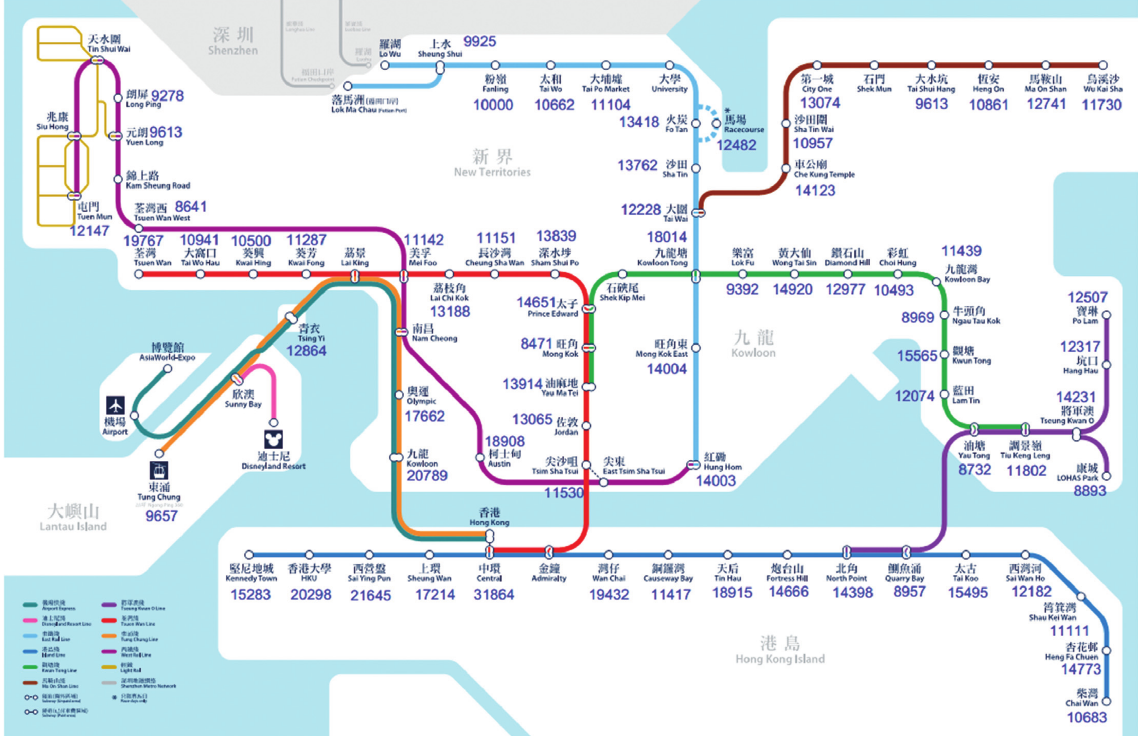
Figure 3: The housing unit prices map around MTR stations for Hong Kong in the first half-year of